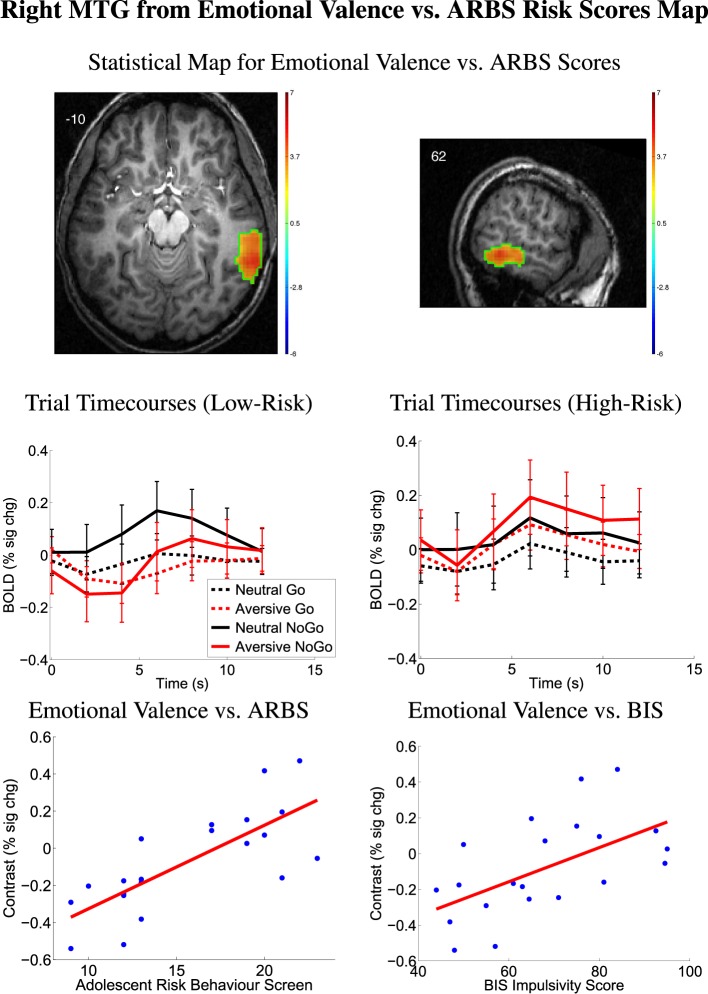
Top row: Statistical t-map for regression of ARBS risk scores against fMRI emotional valence contrast (aversive − neutral distractors). Red/yellow regions exhibited larger contrast magnitudes in participants with higher ARBS risk scores. All results p < 0.05 (corrected for multiple comparisons). Color bars indicate t-value scaling. Slice X- or Z-coordinate in MNI space shown in upper-left. Axial image's left side corresponds to left side of brain. MTG: middle temporal gyrus. Second row: Mean deconvolved timecourses for four trial types for region outlined in green in first row. Error bars denote mean across all participants' standard error of mean activation time course values. Timecourses denoted Low-Risk were computed from 11 low-risk participants with ARBS risk scores ≤ 13. Timecourses denoted High-Risk were computed from 10 high-risk participants with ARBS risk scores ≥17. Bottom row: Scatter plots show emotional valence contrast magnitude vs. participants' ARBS risk scores (left) and vs. BIS impulsivity scores (right) for right MTG region outlined in green in first row. Red line shows linear regression of contrast magnitude against participant ARBS or BIS scores.